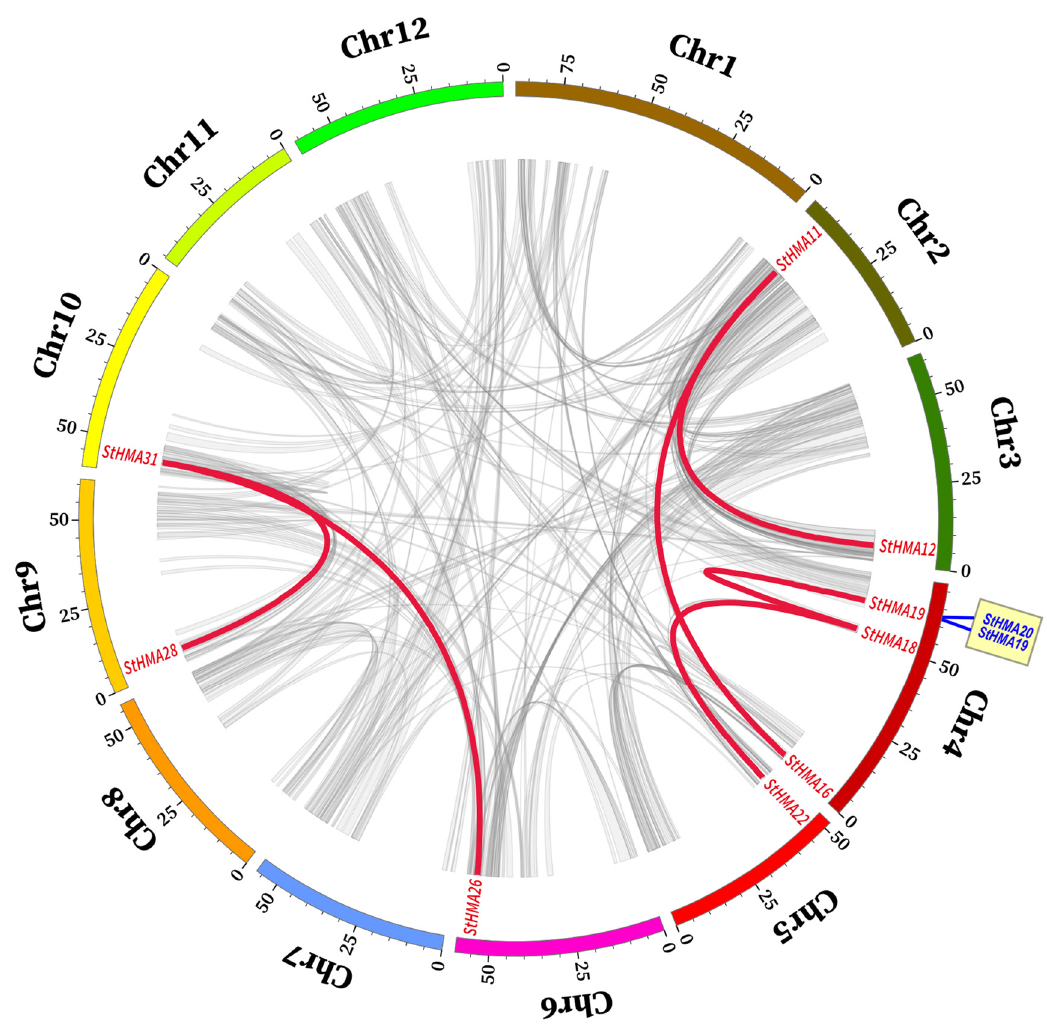
Figure 2. Schematic representations of segmental duplications of Solanum tuberosum StHMA genes. Different gray lines indicate all synteny blocks in potato genome between each chromosome. Thick red lines indicate segmental duplication heavy-metal-associated gene pair, and thick blue lines indicate tandem duplication gene pair. The chromosome number is indicated at the bottom of each chromosome. Scale bar marked on the chromosome indicating chromosome lengths (Mb).